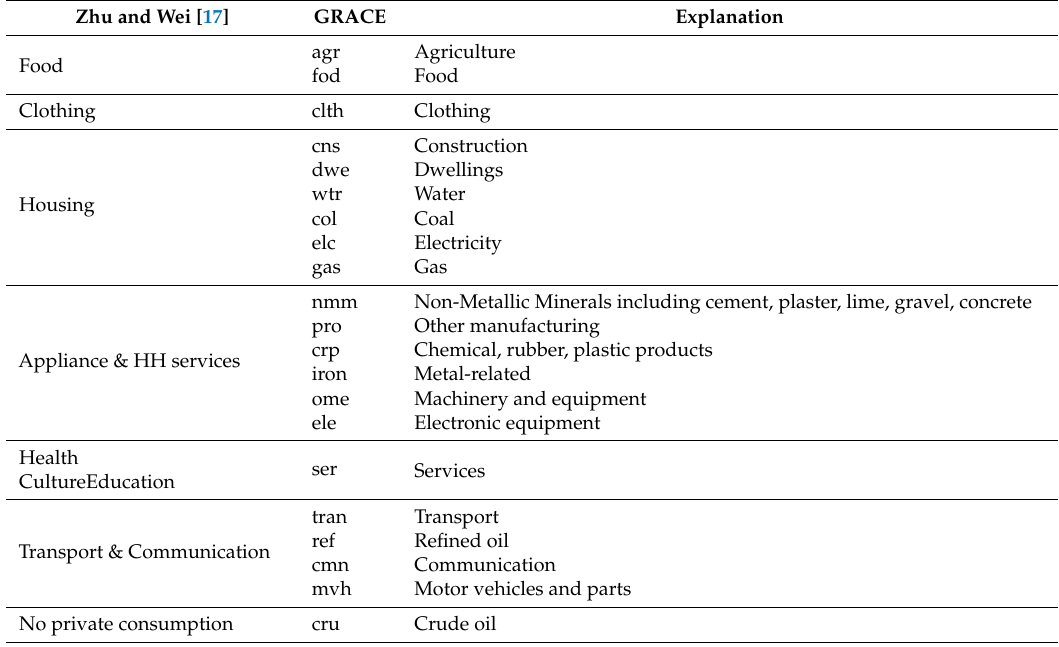
Table 1. GRACE sectors and relations to categories of consumer expenditure in Zhu and Wei